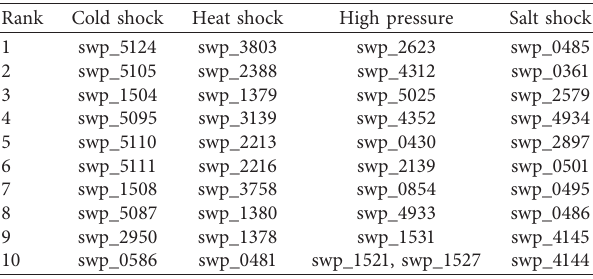
Table 1: The top 10 key proteins in the condition-specific PPI networks of S. piezotolerans WP3 under various environmental